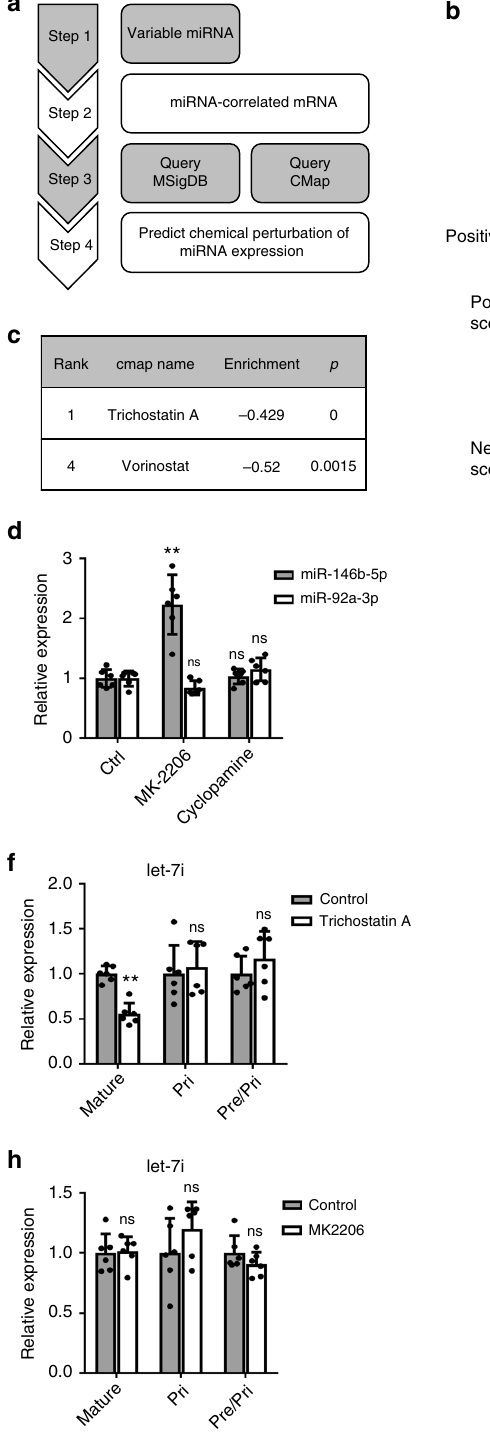
expression. We treated K562 cells with an allosteric AKT inhibitor MK-2206, which signi fi cantly increased miR-146b-5p expression (Fig. 5d). A similar increase was observed in MCF-7 cells (Supplementary Figure 11a). In contrast, MK-2206 did not affect miR-92a-3p or let-7i-5p (Fig. 5d, h), and the inhibition of the hedgehog pathway by cyclopamine or the inhibition of HDAC by Trichostatin A did not signi fi cantly affect miR-146b-5p expression in K562 cells (Fig. 5d, g), indicating the speci fi city at